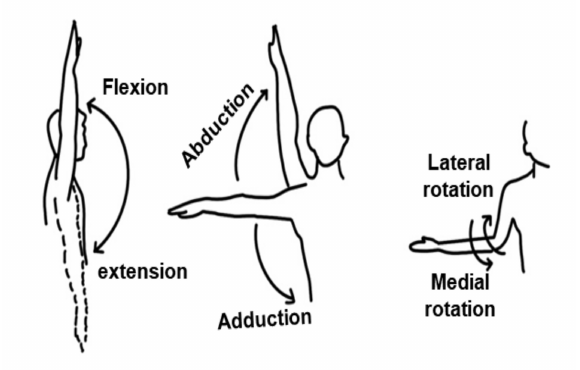
Figure 1. Scapular planes of motion.